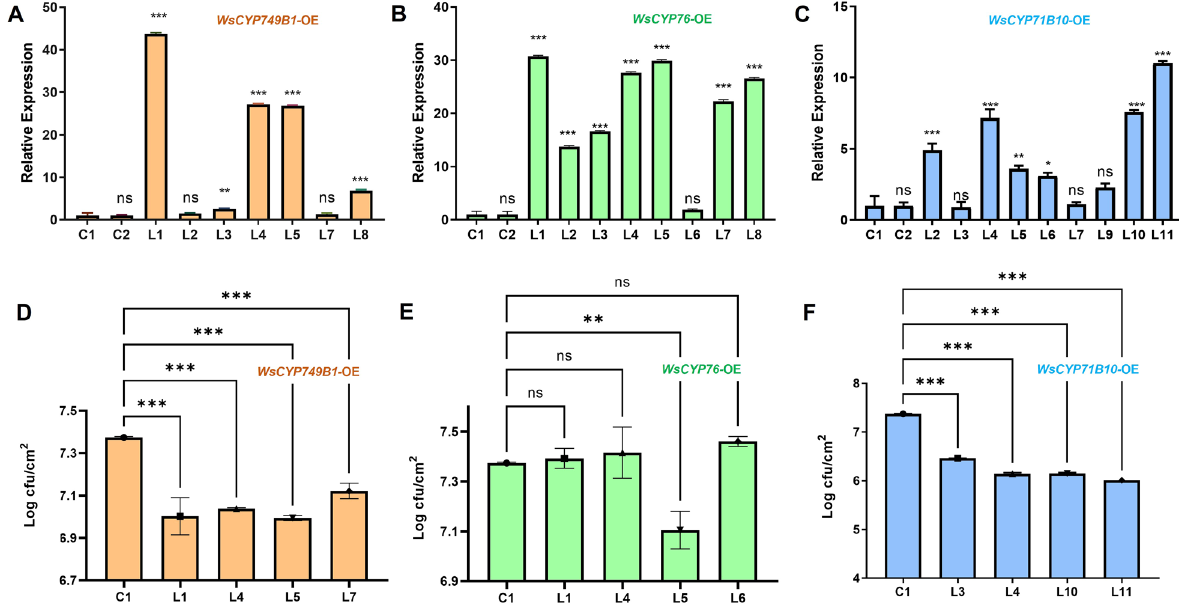
Figure 6. Analysis of gene expression and bacterial growth in transgenic tobacco overexpressing WsCYP450s . ( A , C , E ) Expression levels of WsCYP450 genes in different transgenic tobacco lines. Expression levels of WsCYP450s were normalized to internal reference NtEF1α and arerepresented as expression relative to pBI121 control that was set to 1. ( B , D , F ) Bacterial growth assay with P. syrinage (DC3000) strains. Growth assay was performed by infiltrating leaves of control and transgenic WsCYP450 -OE lines with P. syringae (DC3000). The bacterial growth (CFU) at 3 dpi was obtained by plating serial dilutions. Error bars show mean ± SE of three independent experiments. Statistical significance represented as * p < 0.033, ** p < 0.002, *** p < 0.001, a significant